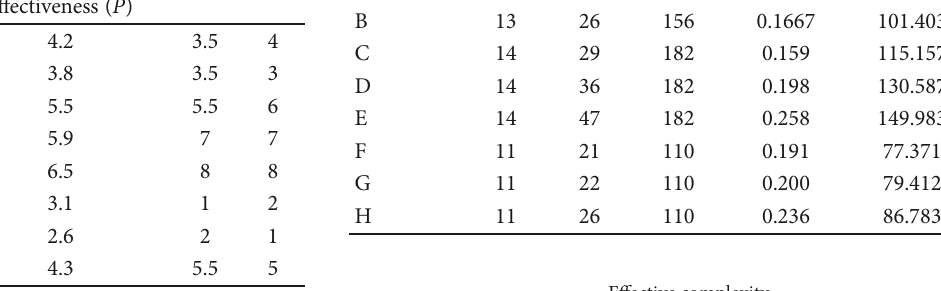
Table 4: Data for Spearman correlation coe ffi cient calculation. Cyclomatic Diagram